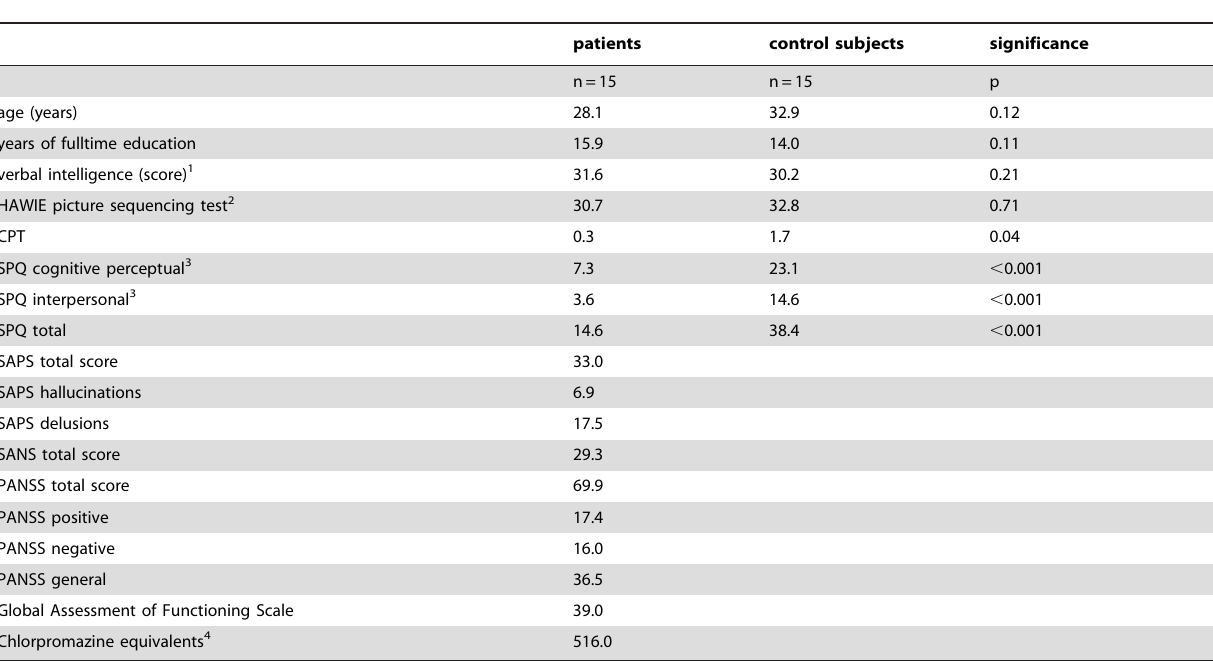
Table 1. Clinical and sociodemographic characteristics of patient and control